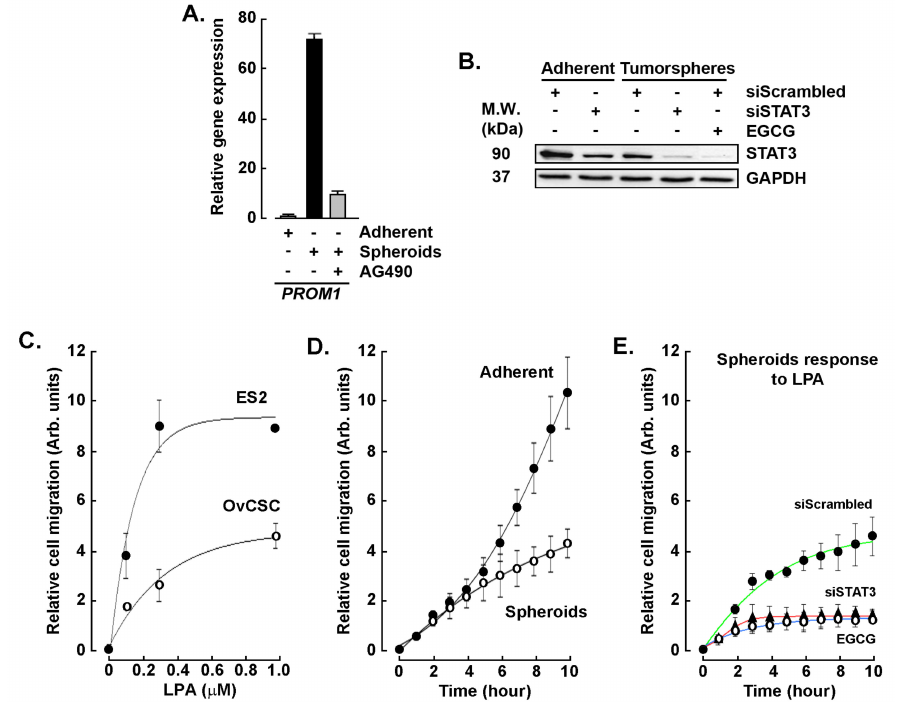
Figure 6. STAT3 regulates the chemotactic response of ovarian cancer tumorspheres to lysophos- phatidic acid. Transient gene silencing of STAT3 (siSTAT3) was performed in adherent ES-2 ovarian cancer cell monolayers as described in the Methods section. Control cells were transfected with a siRNA scrambled sequence. Tumorspheres were next generated as described in the Methods section in the absence or presence of 30 µ M EGCG. ( A ) PROM1 gene expression was assessed by RT-qPCR in either ES-2 monolayers, and in spheroids generated in the presence or not of the JAK/STAT3 inhibitor AG490. ( B ) Cell lysates were isolated and levels of STAT3 and GAPDH proteins were assessed by Western blotting from the siScrambled- or siSTAT3-transfected cells. Tumorspheres were also generated in the presence of 30 µ M EGCG. ( C ) Real-time cell migration was performed to assess ES-2 monolayer cells or commercially available OvCSC chemotactic response to increasing concentrations of Lysophosphatidic Acid (LPA). ( D ) Adherent and tumorsphere cell migration was assessed in time in response to 1 µ M LPA. ( E ) Real-time cell migration of tumorspheres where STAT3 was silenced (siSTAT3) or not (siScrambled) was assessed as described in the Methods section in response to LPA and in the presence or absence of 30 µ M